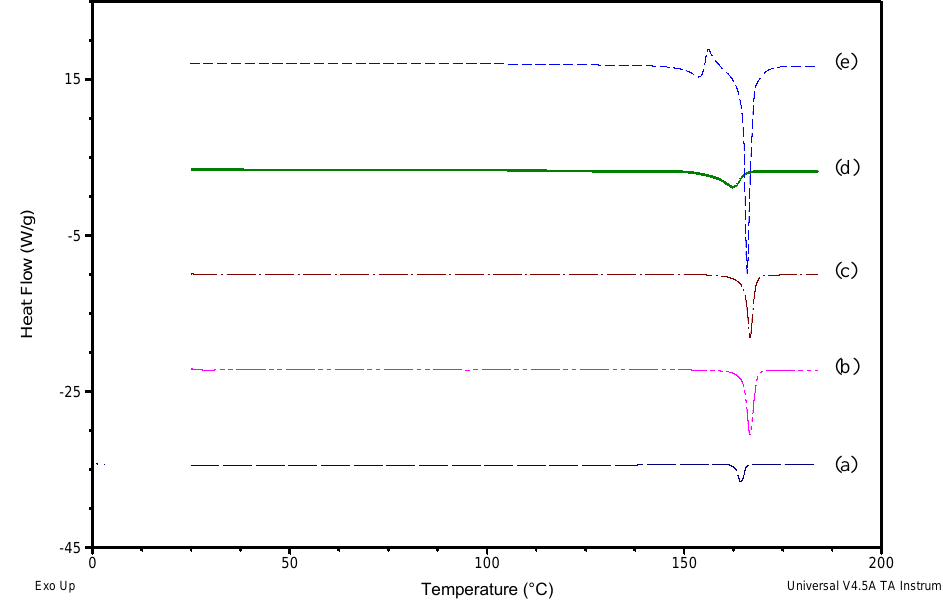
Figure 1. Differential Scanning Calorimeter (DSC) heating curves of ( a ) Dipyridamole (DPM) ( b ) Mannitol (MAN) ( c ) DPM-MAN physical mixture (PM) ( d ) Nanosuspension (NS) and ( e ) Nanocrystalline solid dispersion (NSD).